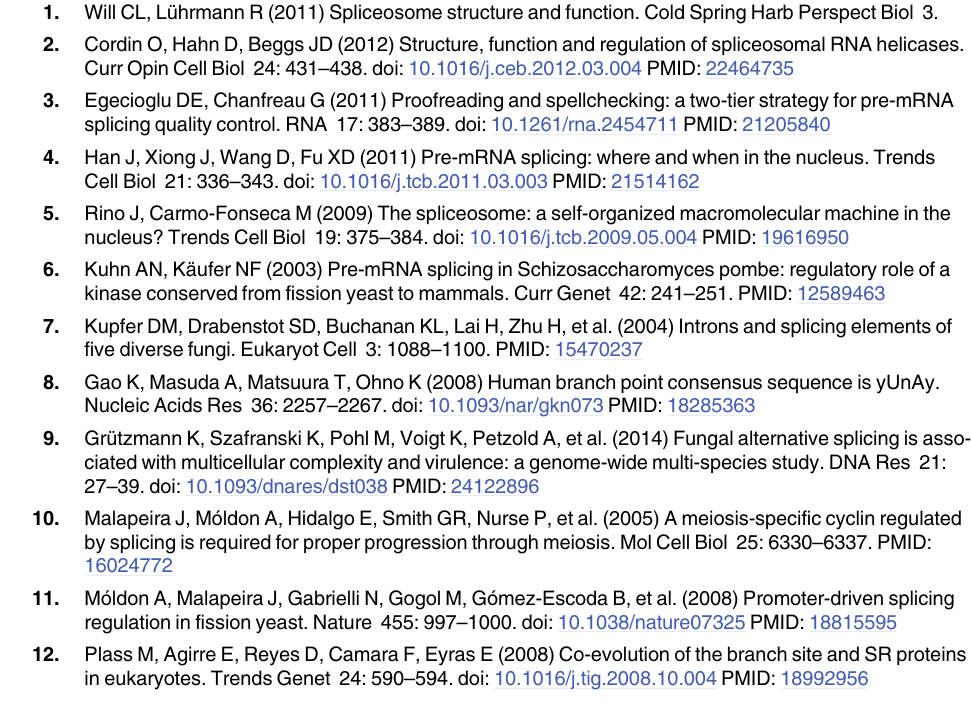
S3 Fig. Prp4 kinase-independent and Prp4 kinase-dependent introns remain what they are, if inserted into the naturally intronless ura4 gene. The intron II of the ade2 gene (383 bp; RSEI +2,28; Prp4 kinase-independent) was inserted into the naturally intronless ura4 gene (strain 933) as well as the intron of the res1 gene (127 bp; RSEI -1,36; Prp4 kinase-dependent; strain 930). RT-PCR analysis in the absence (-Inh) and presence (+Inh) of inhibitor at the indi- O, negative control without template. The numbers on the right side of the cated times. H 2 image represent the sizes of the RT-PCR fragments (bp). Asterisks indicate the expected posi- tion of fragments if the introns are not spliced out. The numbers on the left side of the images represent the sizes of the DNA fragments (bp). M, DNA size marker.